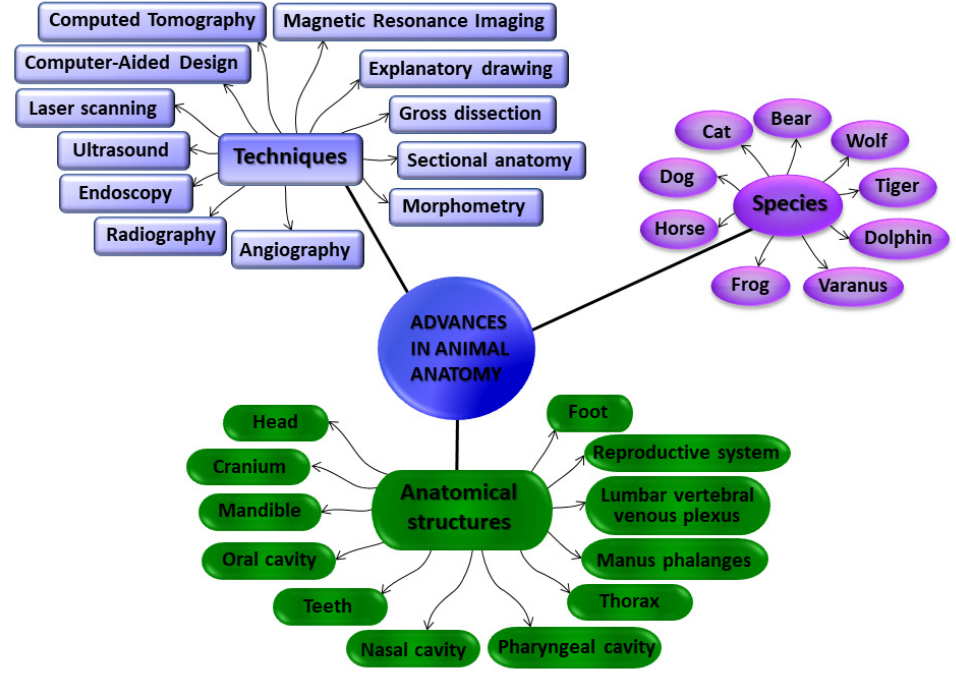
Figure 2. A mind map of this Special Issue summarizing the techniques used to study the different anatomic structures from the diverse